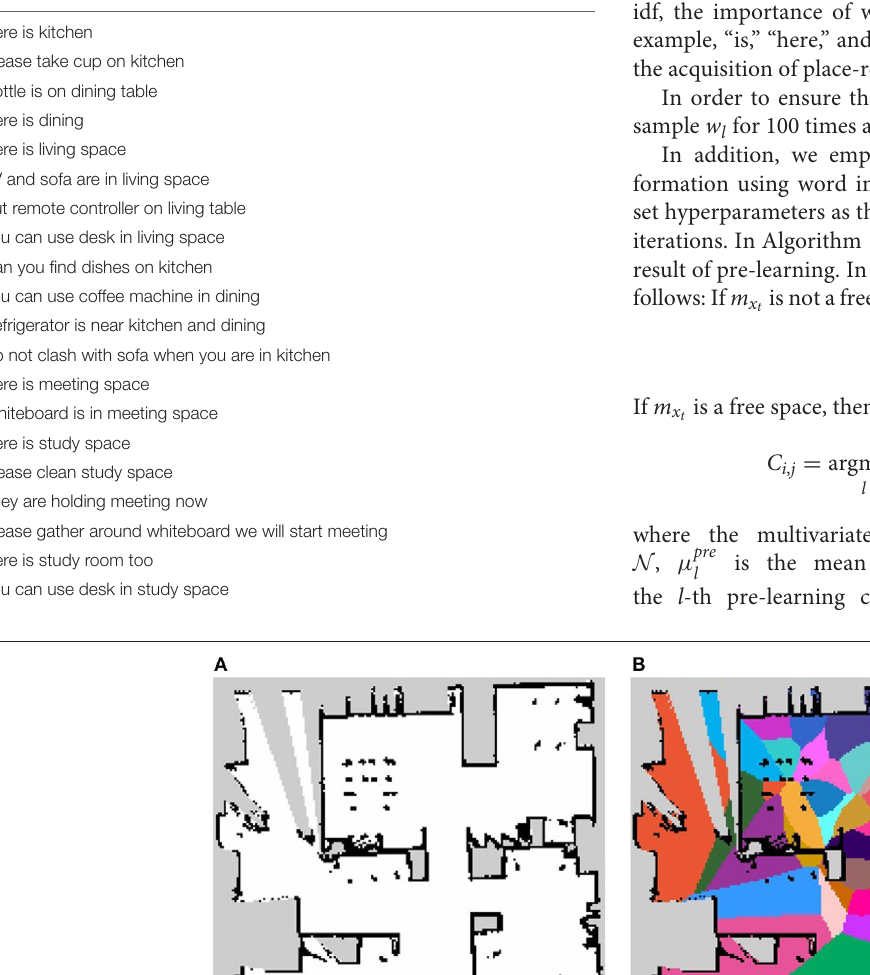
Frontiers in Robotics and AI |